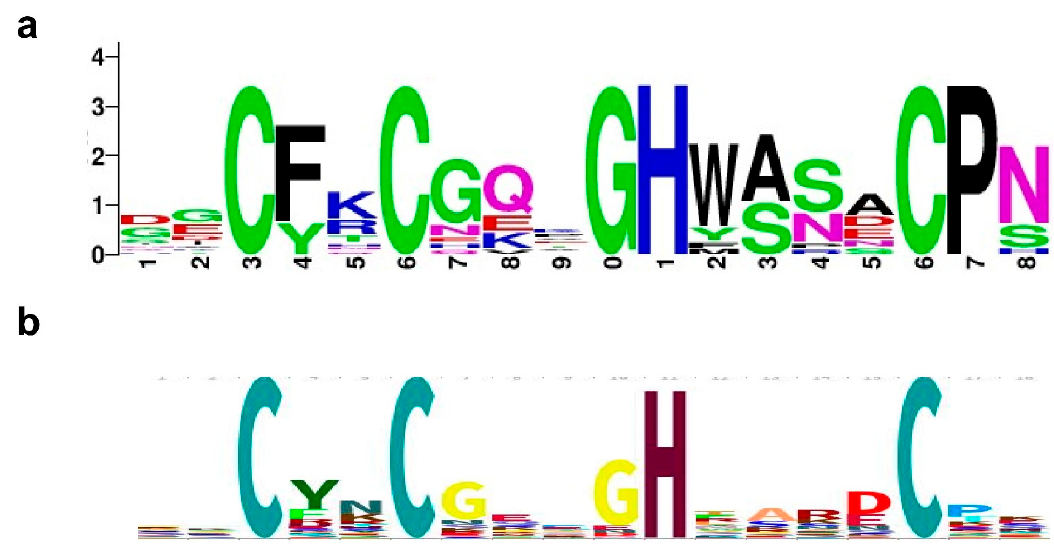
Figure 5. Comparison of consensus sequence for fungal Top3 zf-CCHC from sequences of all zf-CCHC found in eukaryotes in the Pfam database. ( a ) Logo sequence for zf-CCHC in fungal topoisomerase III (from 23 sequences found in 13 species shown in Table S2). ( b ) HMM logo of all sequences in the Pfam database for zf-CCHC (PF00098, sequences from 1680 species).